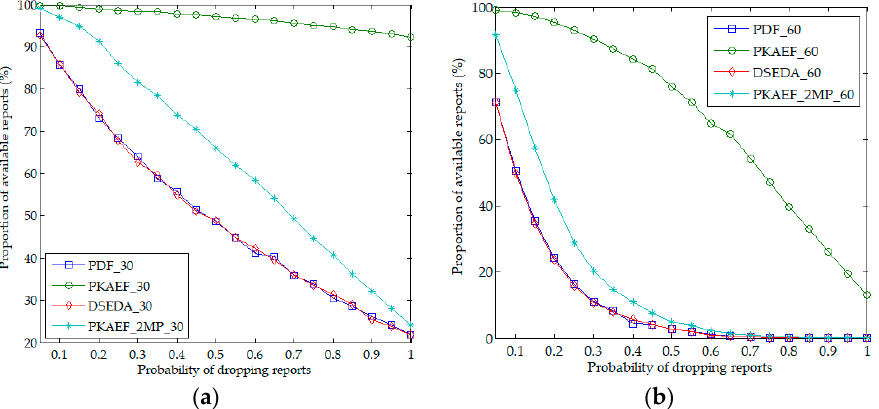
Figure 7. Proportion of available reports as a function of the probability of dropping reports. ( a ) in Scenario 1; ( b ) in Scenario 2.